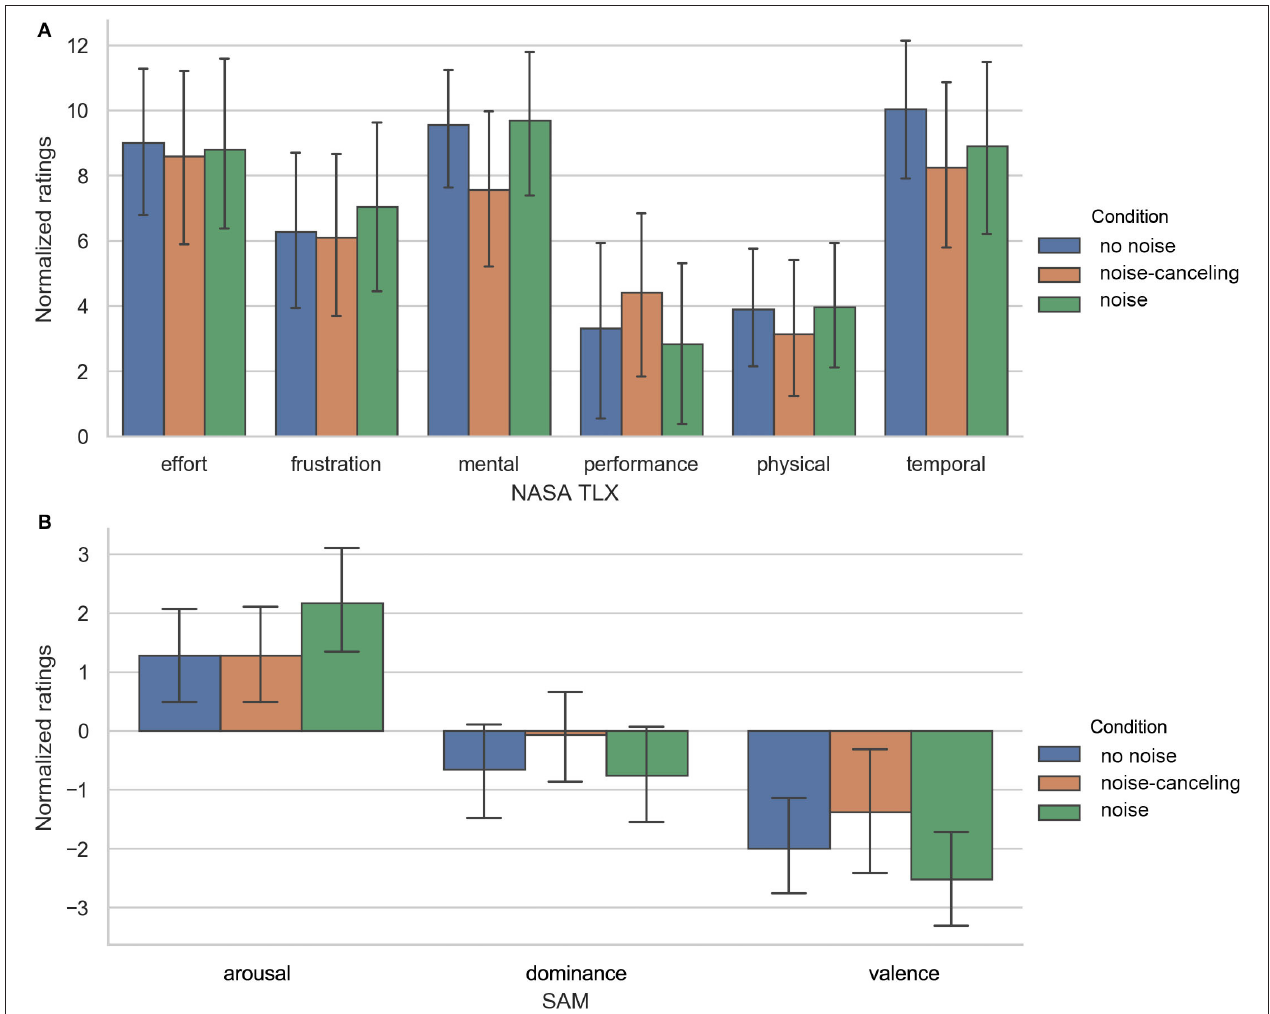
FIGURE 3 | (A) Normalized values for NASA TLX. Ratings from before were subtracted from ratings after . Error bars show 95% confidence interval. (B) Normalized values for SAM. Error bars show 95% confidence